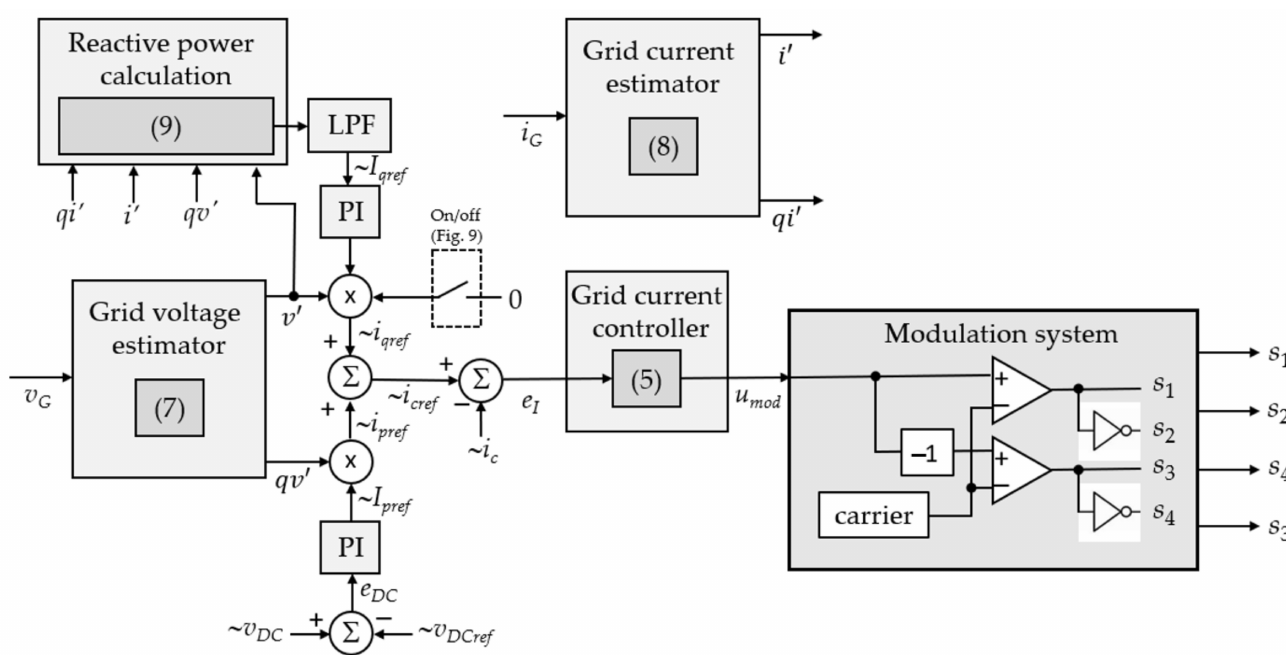
Figure 4. The structure of the current control system of the